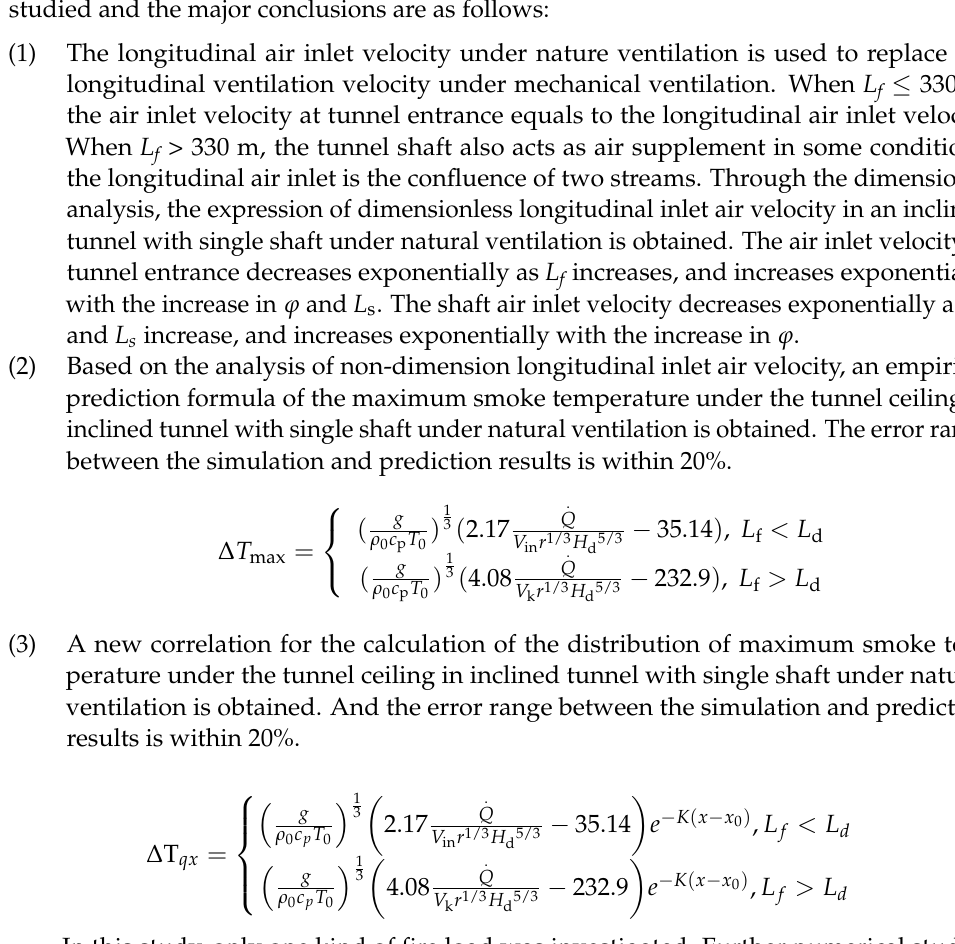
Figure 19. Comparison of numerically measured ∆ T qx values and the predictions by Equation (14).